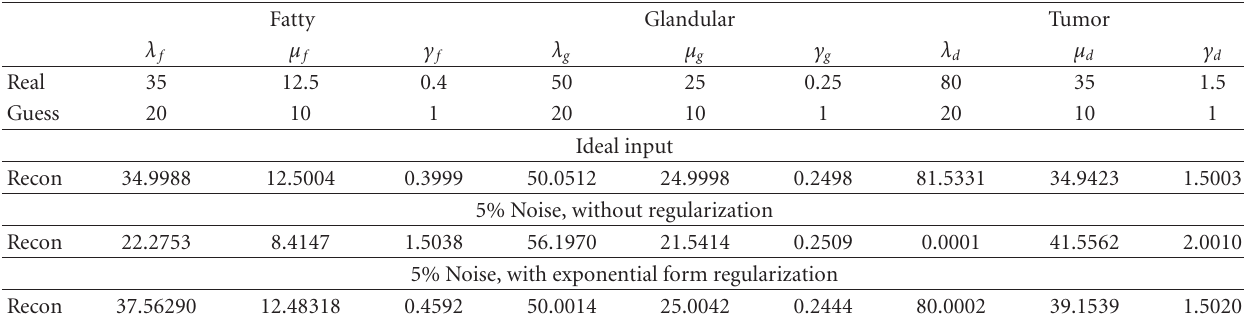
Table 1: Initial estimate and reconstructed results for nonlinear elastogrpahy. The results in the first part are based on ideal input (without noise). The ones in the second part are based on input with 5% noise and regularization is not used. The third part is based on input with 5% noise and regularization is applied to reduce the impact of noise. ( λ and μ are dimensionless, γ is in